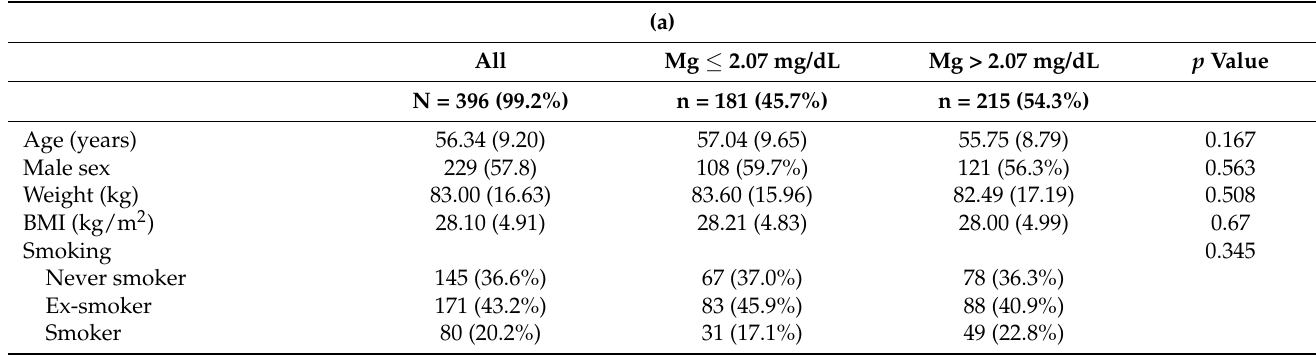
Table 1. ( a ): Demographic and cardiovascular risk factors by serum magnesium status; ( b ): demo- graphic and cardiovascular risk factors by dietary magnesium